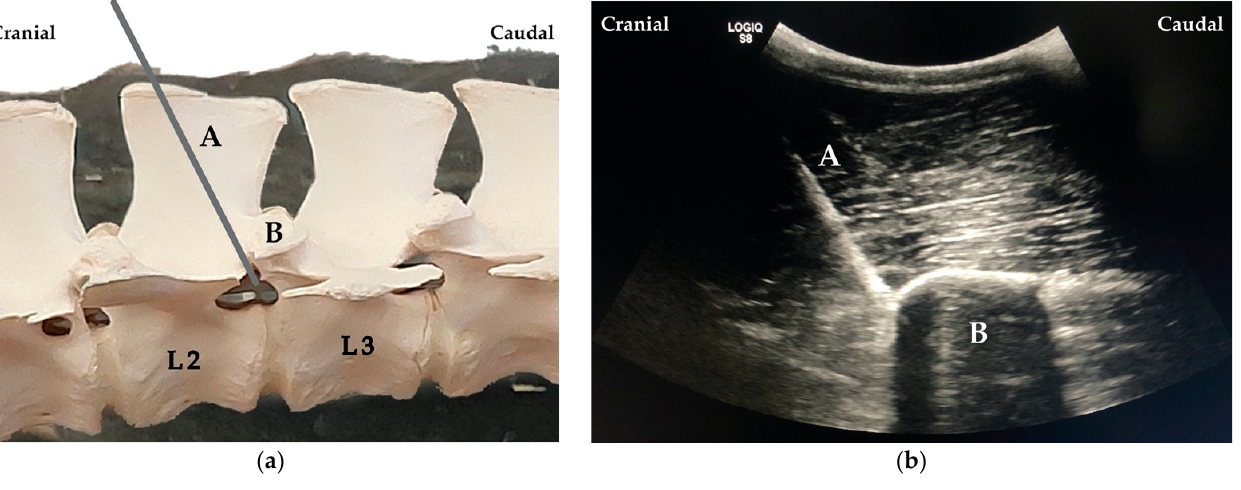
Figure 4. ( a ) Needle (A) placement cranial to the articular process of the second lumbar (L2) vertebra (B). ( b ) Ultrasound image showing the needle (A) cranially to the articular process of the vertebra L2 (B).